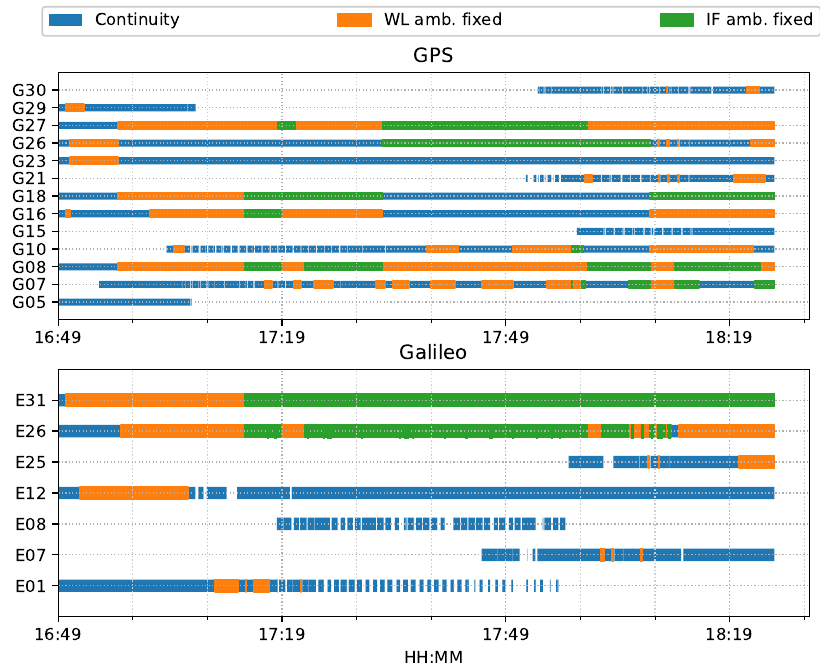
Figure 8. Time span of observed satellites and the fixed ambiguity states of PPP-AR train positioning test on 7 March